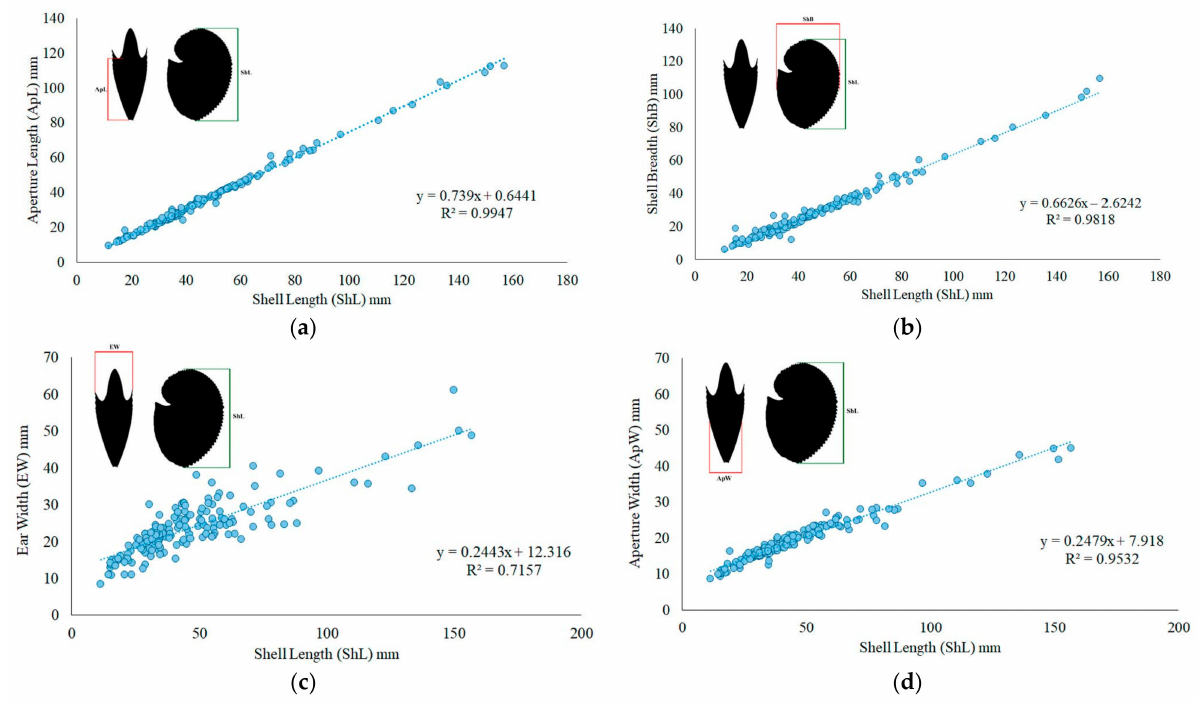
Figure 3. Morphometric relationships between the “shell” length (ShL) and: ( a ) aperture length (ApL); ( b ) “shell” breadth (Shb); ( c ) ear width (EW); ( d ) aperture width